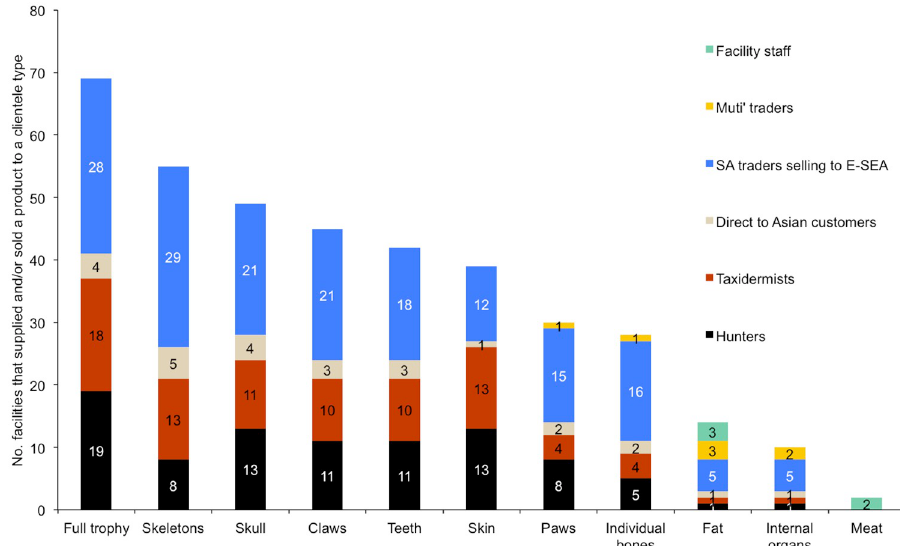
Fig 6. Number of facilities aware of having sold/supplied specific lion products to different clientele. Total respondents n = 52 facilities, where multiple categories and products could be selected for. A ‘full trophy’ includes skeleton, skull, skin, teeth and claws. No responses received for the category ‘Customers in other African countries’. (SA = South Africa; E-SEA = East-Southeast Asia). Results correspond to Question 45.